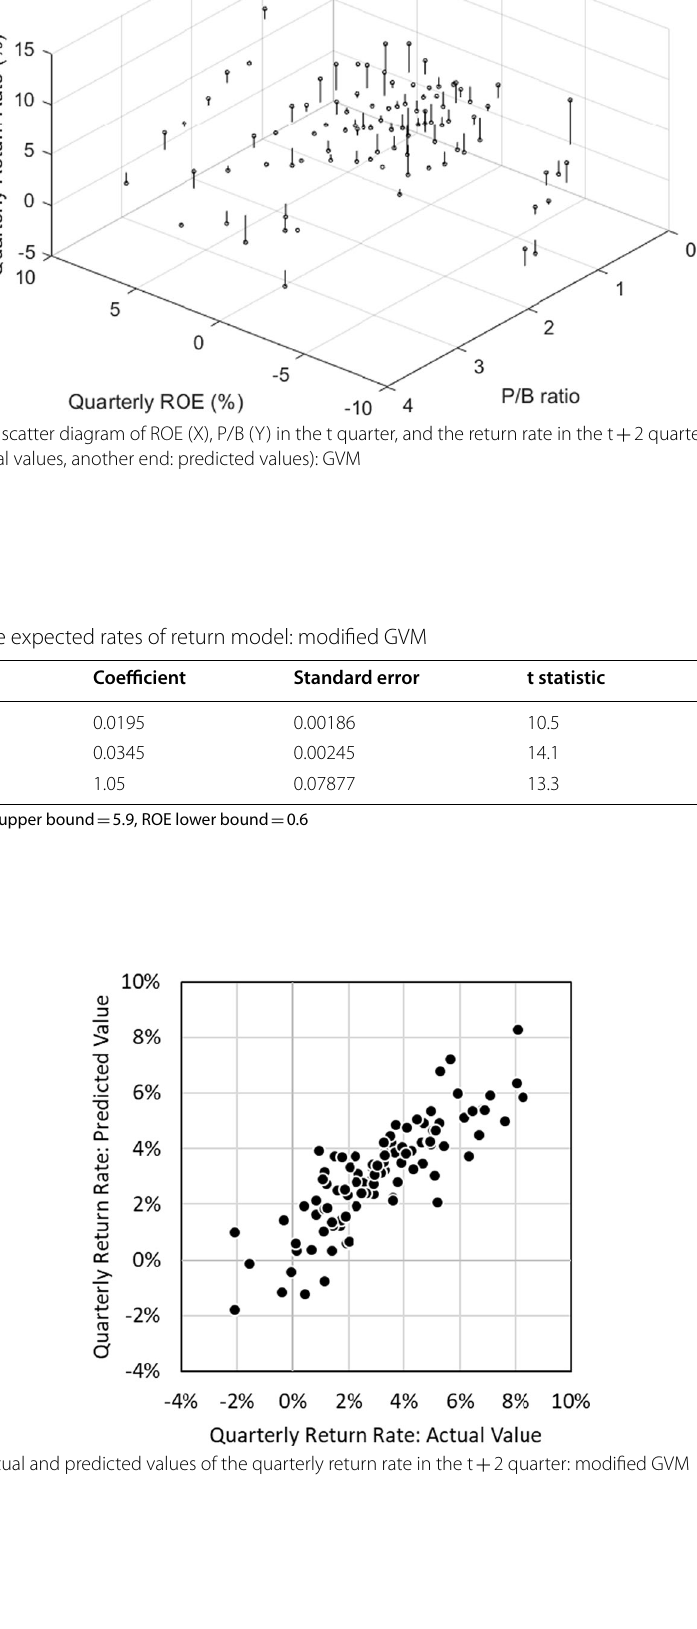
2 quarter: modified +